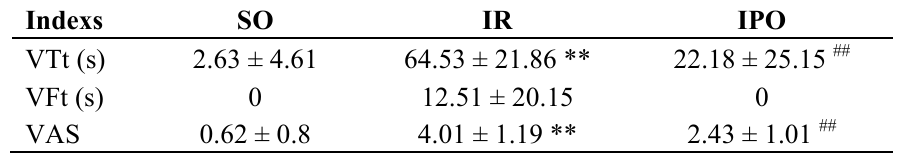
Table 1. Effect of ischemic postconditioning on the value of VTt, VFt and VAS in IR